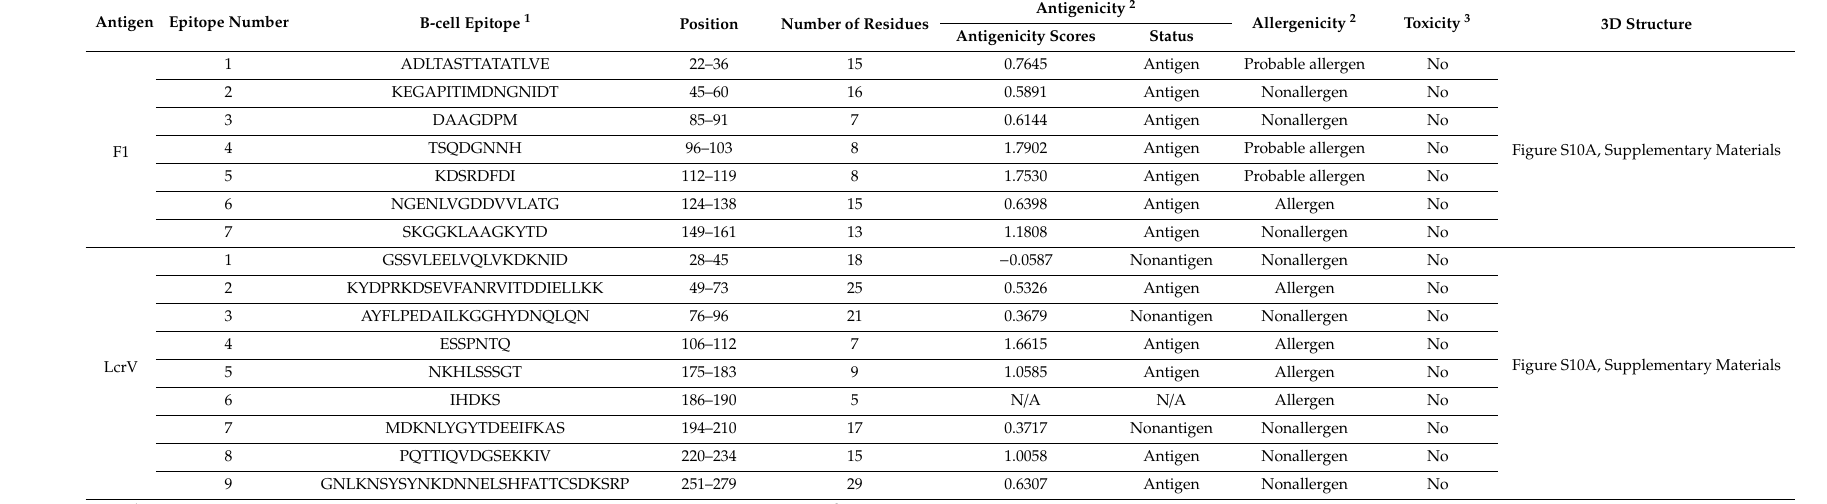
Table 1. Linear B-cell epitopes of F1 and LcrV predicted in